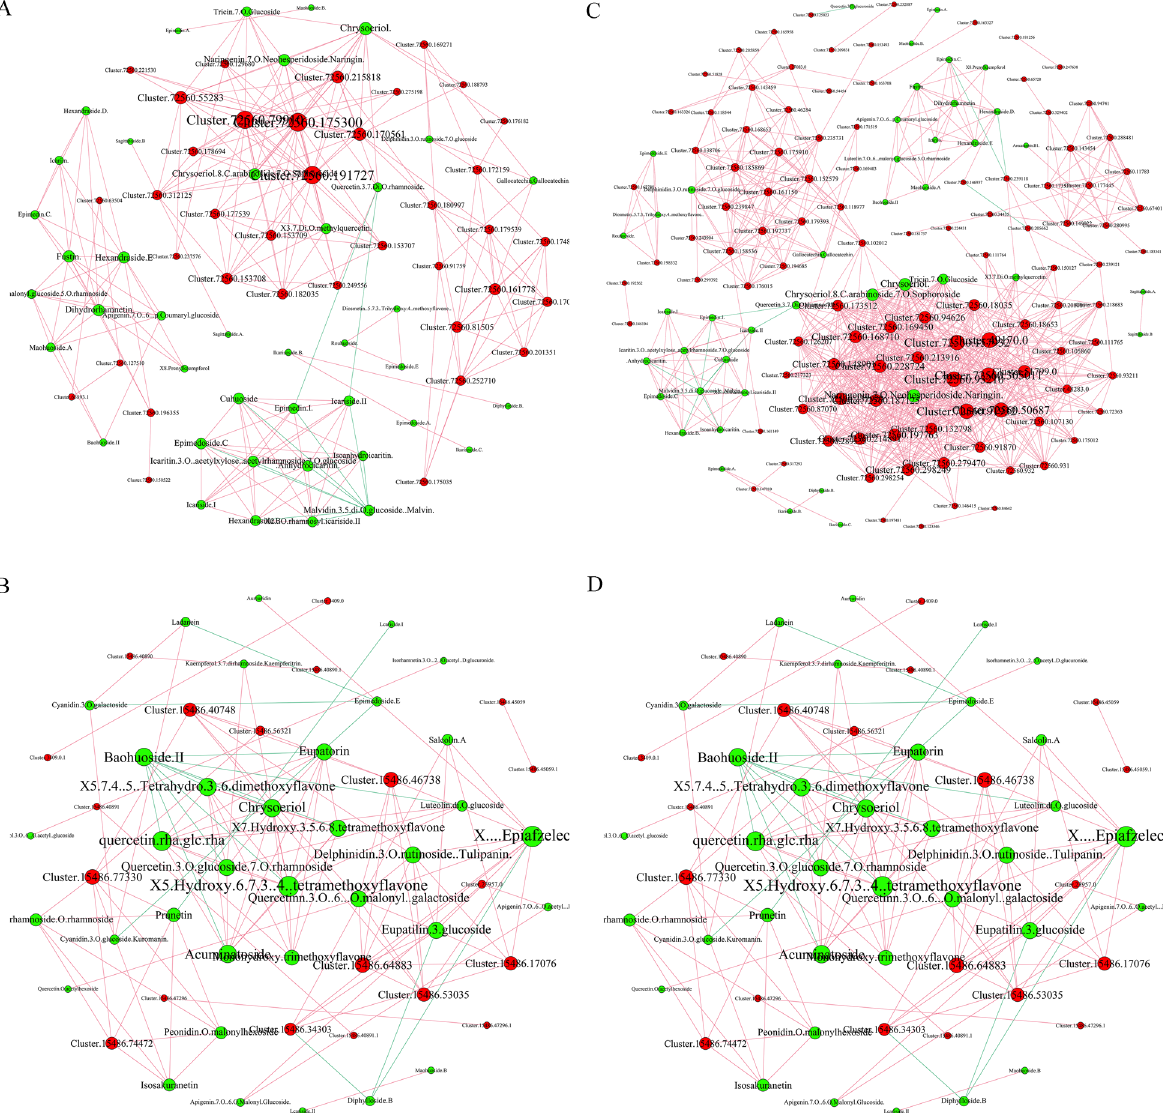
Figure 6. Connection network between flavonoid-biosynthesis or O -methyltransferase-related DEGs and flavonoid DAMs. Red nodes represent genes, green nodes represent metabolites. The size of node represents the number of related genes or metabolites. Red lines represents positive correlation, green lines represents negative correlation. (A) Connection network between DEGs encoding flavonoids biosynthetic enzymes and DAMs in flower. ( B) Connection network between DEGs encoding flavonoids biosynthetic enzymes and DAMs in leaves. ( C) Connection network between DEGs encoding O-methyltransferase and DAMs in flower. ( D) Connection network between DEGs encoding O-methyltransferase and DAMs in